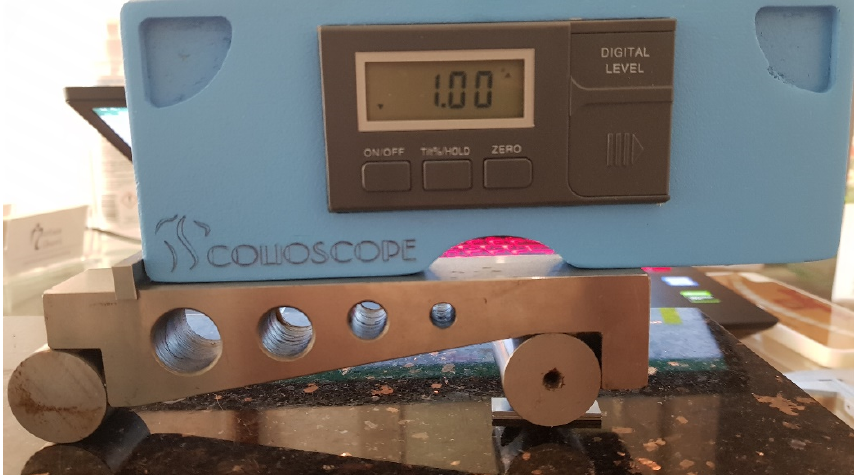
Figure 4. Scolioscope during the accuracy study. Table 1. Angles, sines, and opposites’ calculation for the 5” sine bar. Angle θ ( ◦